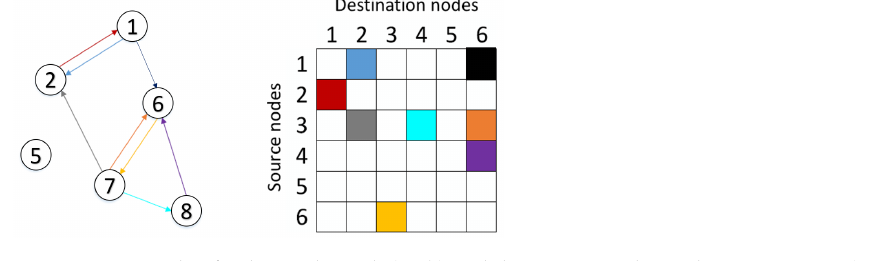
Figure 2. Example of a directed graph ( Left ) and the corresponding adjacency matrix ( Right ). Image adapted from